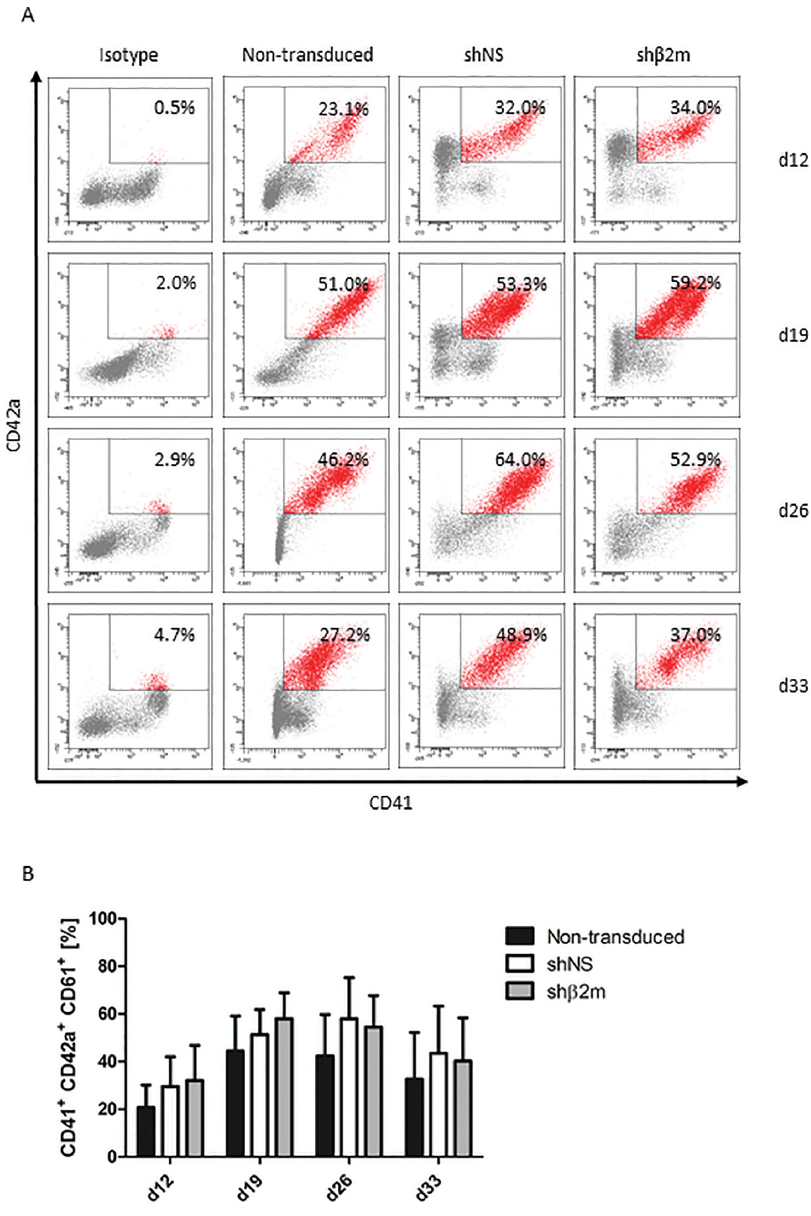
Figure 3. Characterization of iPSC-derived HLA class I-silenced megakaryocytes (MKs). Non- transduced iPSCs and iPSCs expressing either a control nonspecific shNS or a shRNA targeting β 2m transcripts (sh β 2m) were cultured for 33 d and analyzed weekly from d 12 for MK differ- entiation (four time points). iPSCs were transduced with shRNA encoded in a pLVTHm back- bone. (A) MKs were identified based on the expression of CD41 (GPIIb) and CD42a (GPIX). Representative flow cytometry dot plots are shown for each condition and time point. (B) Mean and SD of CD41 + CD42a + CD61 + cell frequencies were detected by at least four independent experiments. (C) Polyploidy analysis of shNS or sh β 2m- expressing CD41 + cells on d 26 and d 33. Representative flow cytometry histograms are shown. (D) Representative fluo- rescence microscopy images of MKs exhibiting polyploid nuclei (lower row) and morpholog- ical analyses of proPLT-forming MKs (upper row). Representative pictures of nontransduced, shNS or sh β 2m-expressing MKs on d 20 of differentiation are shown (bright field). Continued on the next